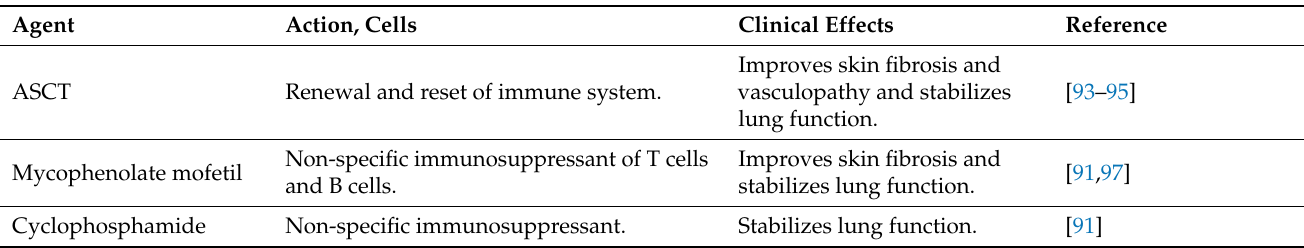
Table 1. Selected therapeutic agents for systemic